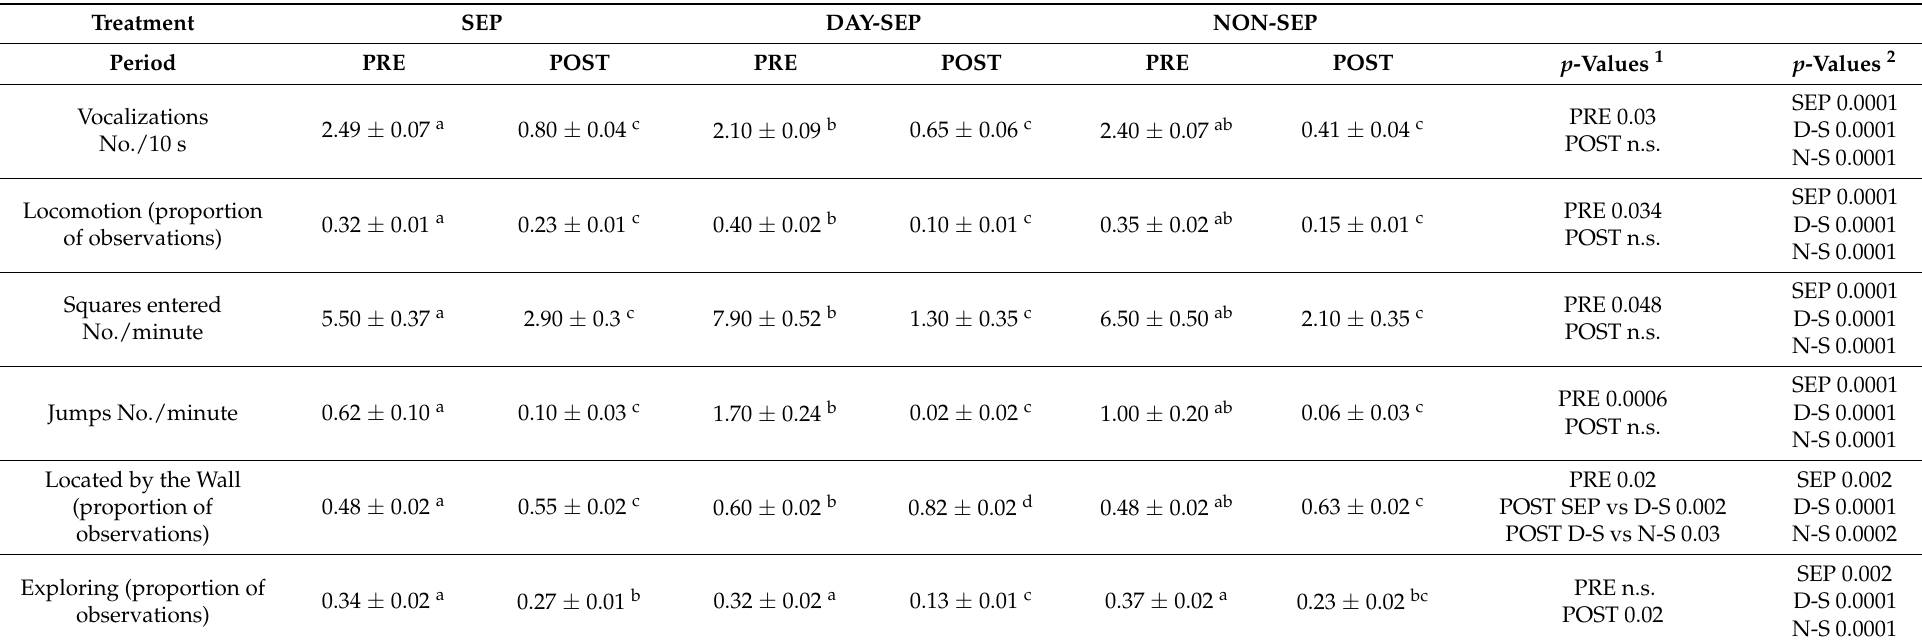
Table 3. Mean values ± SE for behavior during an arena test. SEP = 10 kids separated from their mother, DAY-SEP = 6 kids separated from their mother between 7.30 h and 15.00 h, and NON-SEP = 6 kids kept together with mothers. The arena test lasted for 20 min, with a novel object appearing after 10 min. For purposes of comparison, the arena test was divided into two periods; before novel object (PRE = minute 1–10) and after novel object (POST = minute 11–20). Different letters indicate differences between treatments within periods and within treatments between